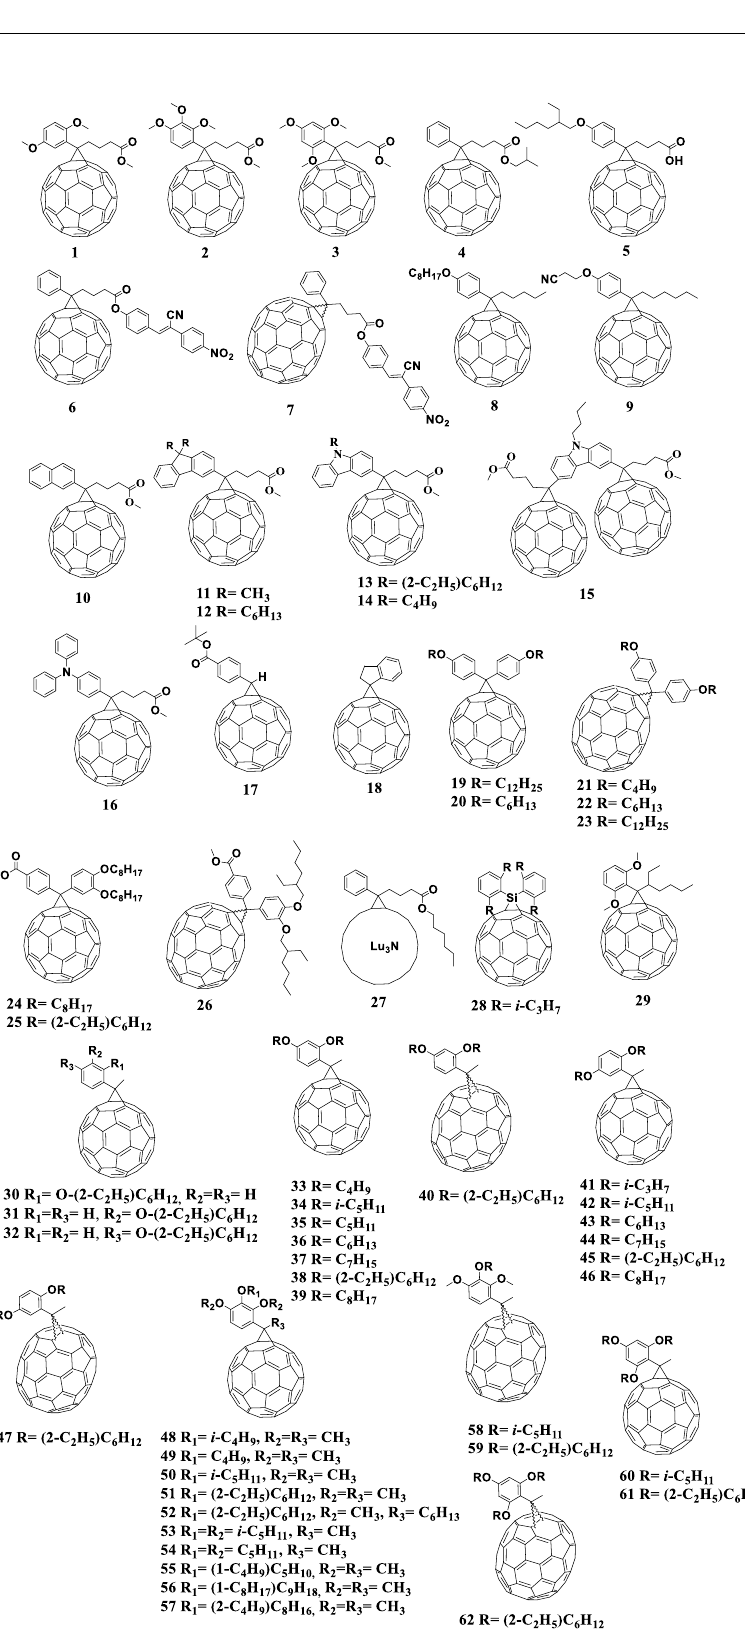
Figure 10. Molecular structures of the cyclopropane derivatives of fullerenes with reduced electron affinity.